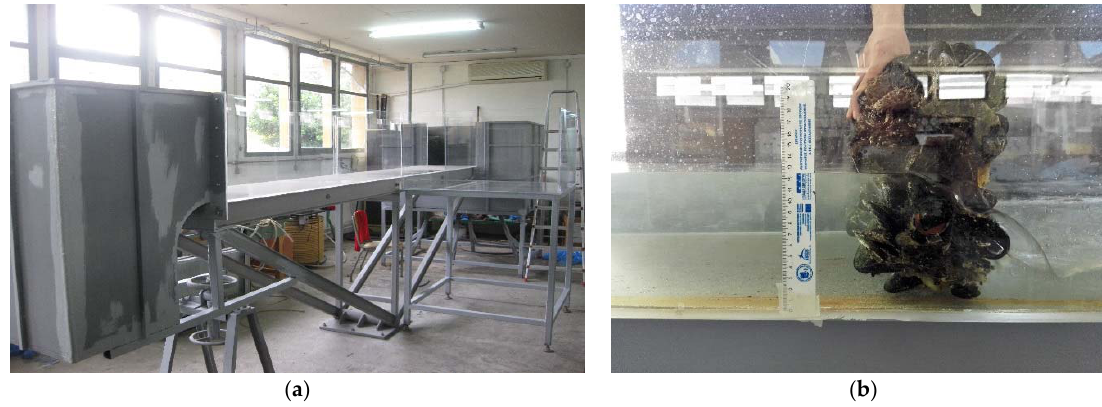
Figure 2. ( a ) Experimental set ‐ up and ( b ) a photograph of a mussel